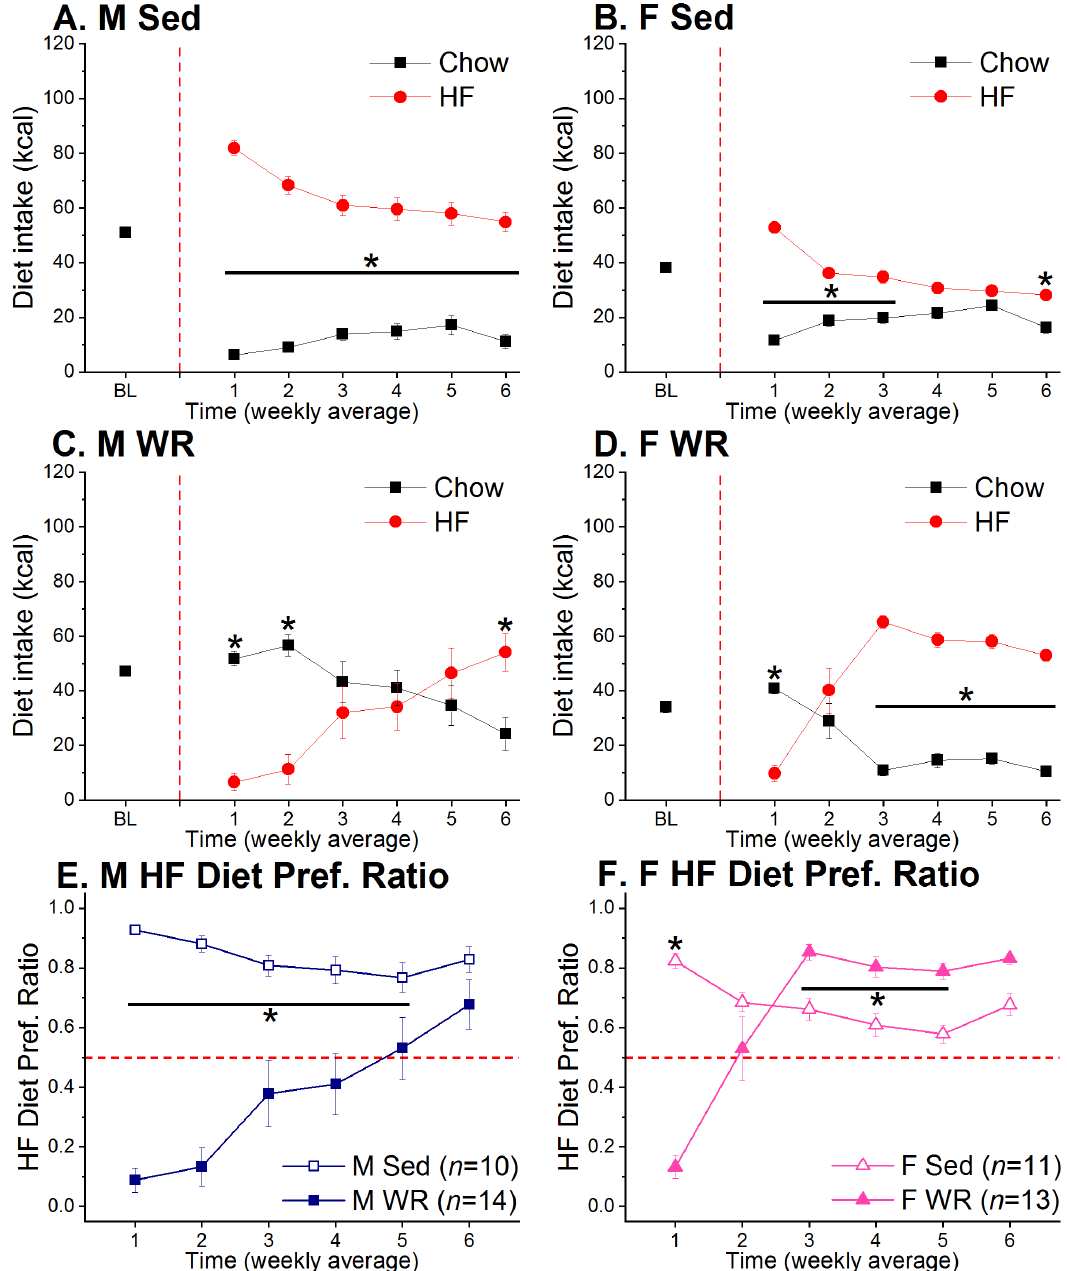
Figure 3. Diet choice and HF diet preference ratios in males (M, left) and females (F, right). WR rats expressed opposite diet choice patterns from their Sed controls. The vertical and horizontal dashed red lines denote the start of the two-diet choice and WR period and preference for HF diet where any value greater than 0.5 indicates a preference for HF diet, respectively. ( A , B ) Sedentary male rats maintained higher intake of HF than chow diet throughout the experiment whereas there was a two-week period in which Sed females did not show a preference for either diet. * chow vs. HF, p < 0.05. ( C , D ) Both male and female WR rats increased HF diet intake across time. The reversal of HF diet avoidance occurred earlier in females than males. * chow vs. HF, p < 0.05. ( E , F ) HF diet preference went in opposite directions among Sed and WR rats in both sexes. * Sed vs. WR, p < 0.05.